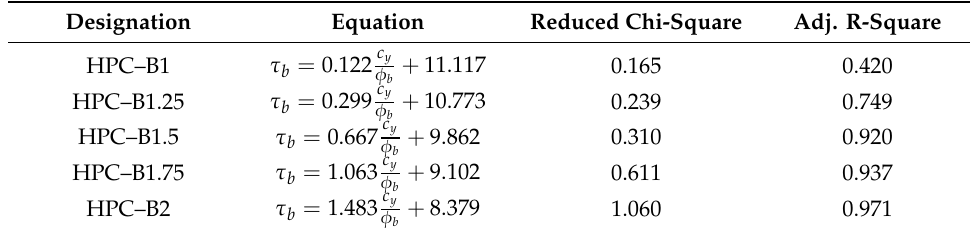
Figure 5. Variation in bond strength with c y / ϕ b ratio for different basalt fibre volume content. Table 6. Ratio of concrete cover to bar diameter—bond strength relationship of basalt fibre reinforced high performance concrete (BFRHPC).